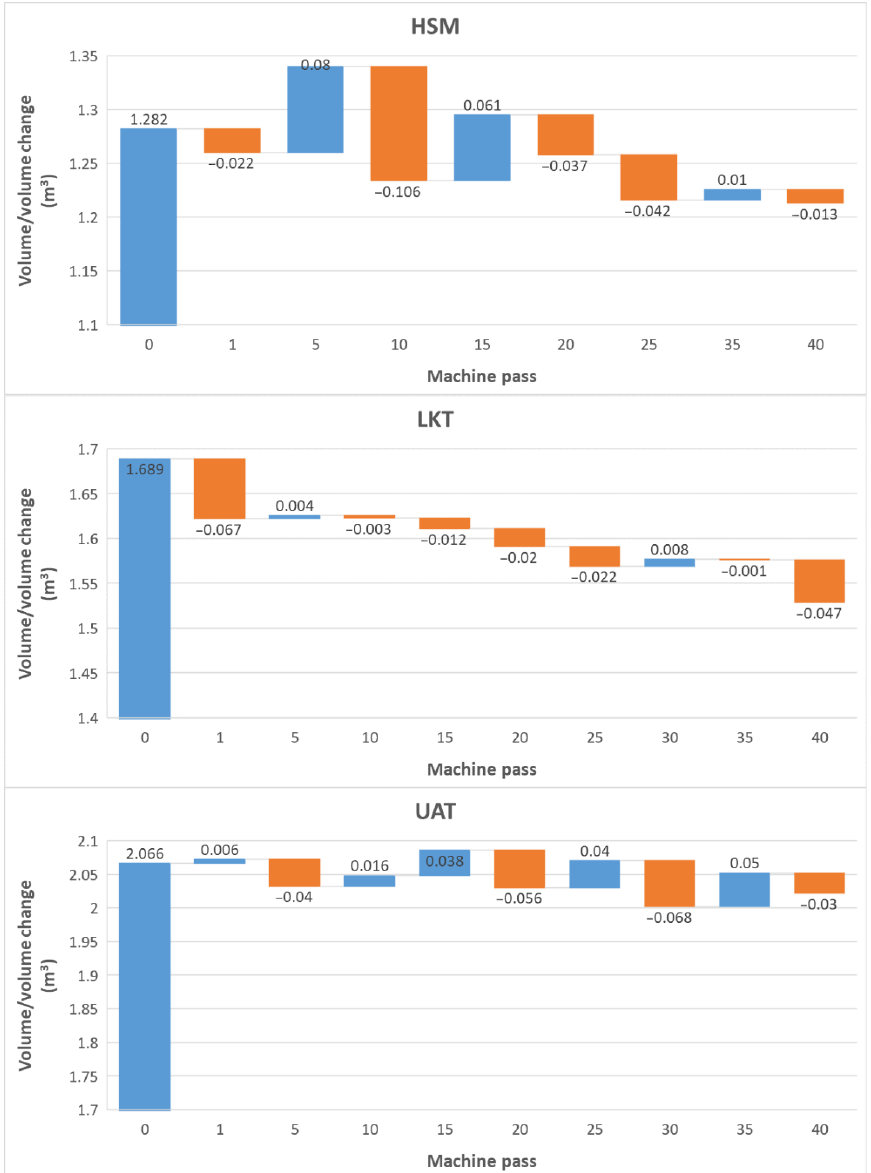
Figure 8. Volume changes after individual passes of the tractors. Blue color indicates an increase in volume, while orange color indicates a decrease in volume. The first column represents the volume before passes.